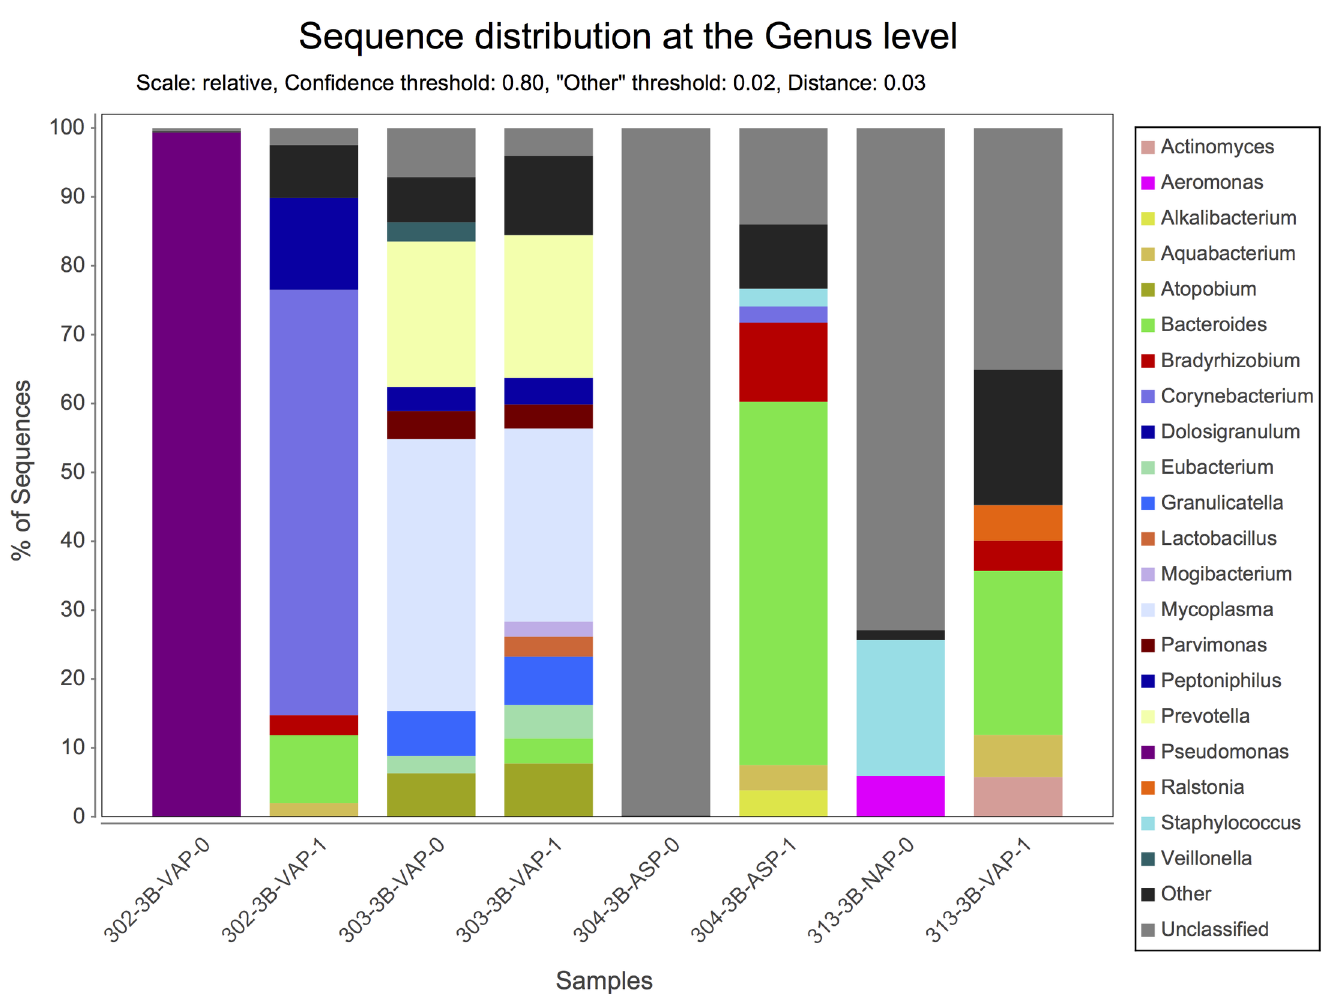
Fig 11. Relative abundance of bacterial microbiota in consecutively sampled patients. Consecutive lower respiratory tract samples of 4 intubated and mechanically ventilated patients with pneumonia. Bacteria are shown at genus level. Unclassified sequences in sample 304-3B-ASP-0 revealed Escherichia/Shigella sp . using a confidence threshold of 0.63. Comparison of these sequences with reference sequences using BLAST yielded uncultured Shigella sp . 16s rRNA genes. Unclassified sequences in sample 313-3B-VAP-0 revealed Enterobacter sp . using a confidence threshold of 0.63. Comparison of these sequences with reference sequences using BLAST yielded uncultured proteobacterium 16s rRNA genes. VAP = Ventilator associated pneumonia, ASP = aspiration pneumonia, NAP = nosocomial acquired pneumonia.